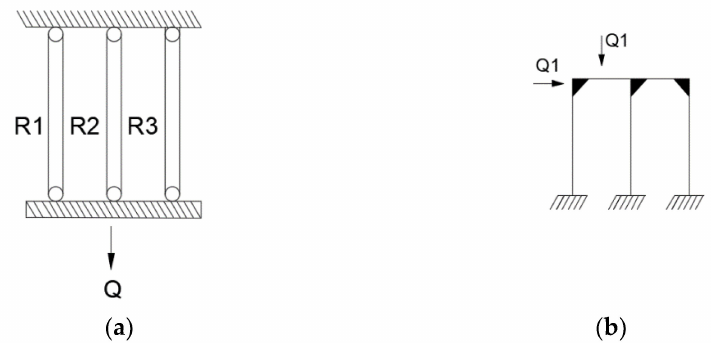
Figure 2. Two simple parallel systems. ( a ) parallel members, ( b ) rigid-plastic frame.